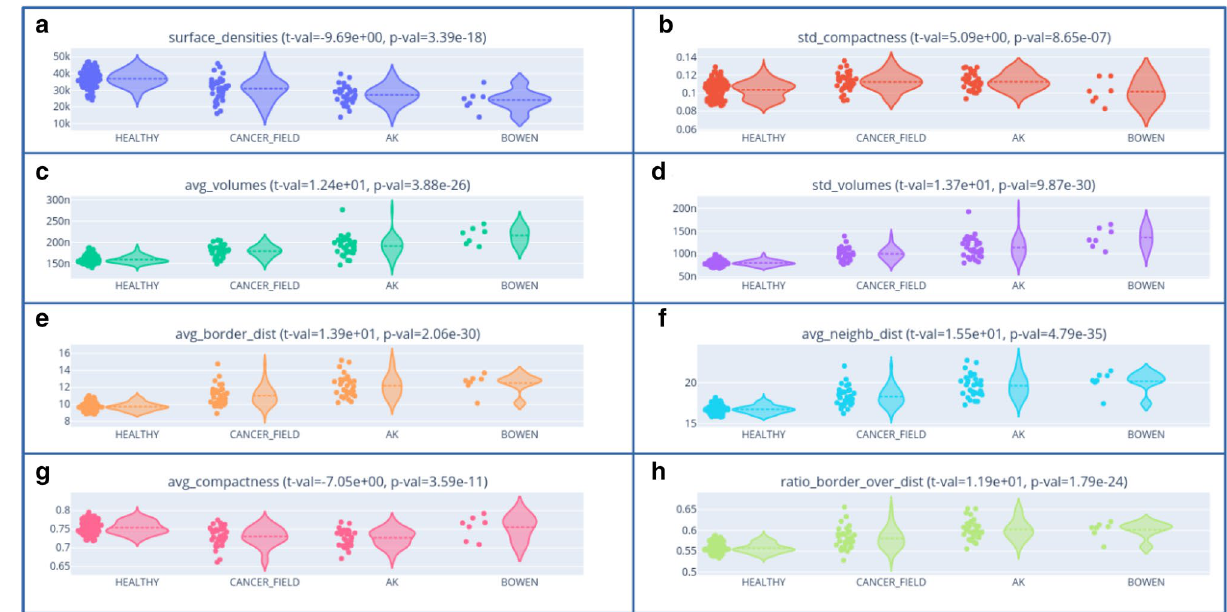
Figure 2. Global metrics per image with their corresponding t-values and p-values for the T-test for the means of two independent samples of